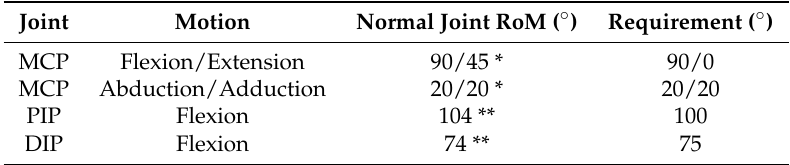
Table 1. Normal ranges of motion for the finger joints and corresponding actuator requirements. RoM, range of motion.